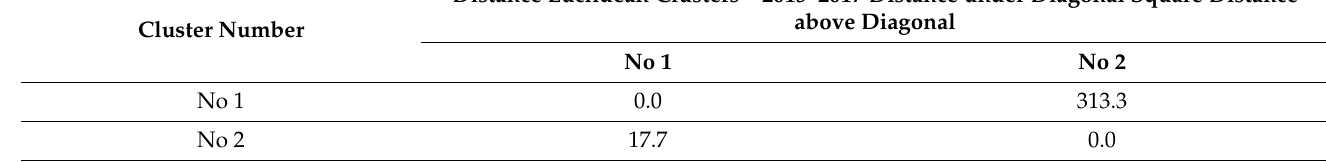
Elements cluster number 1 and distance from center right cluster. Cluster has 1